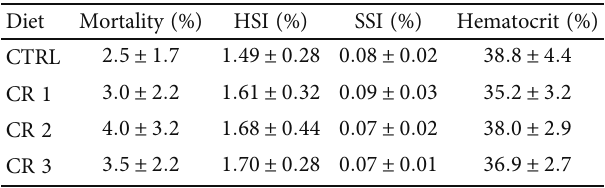
Table 9: Biometric indices of fi sh after 84 days of